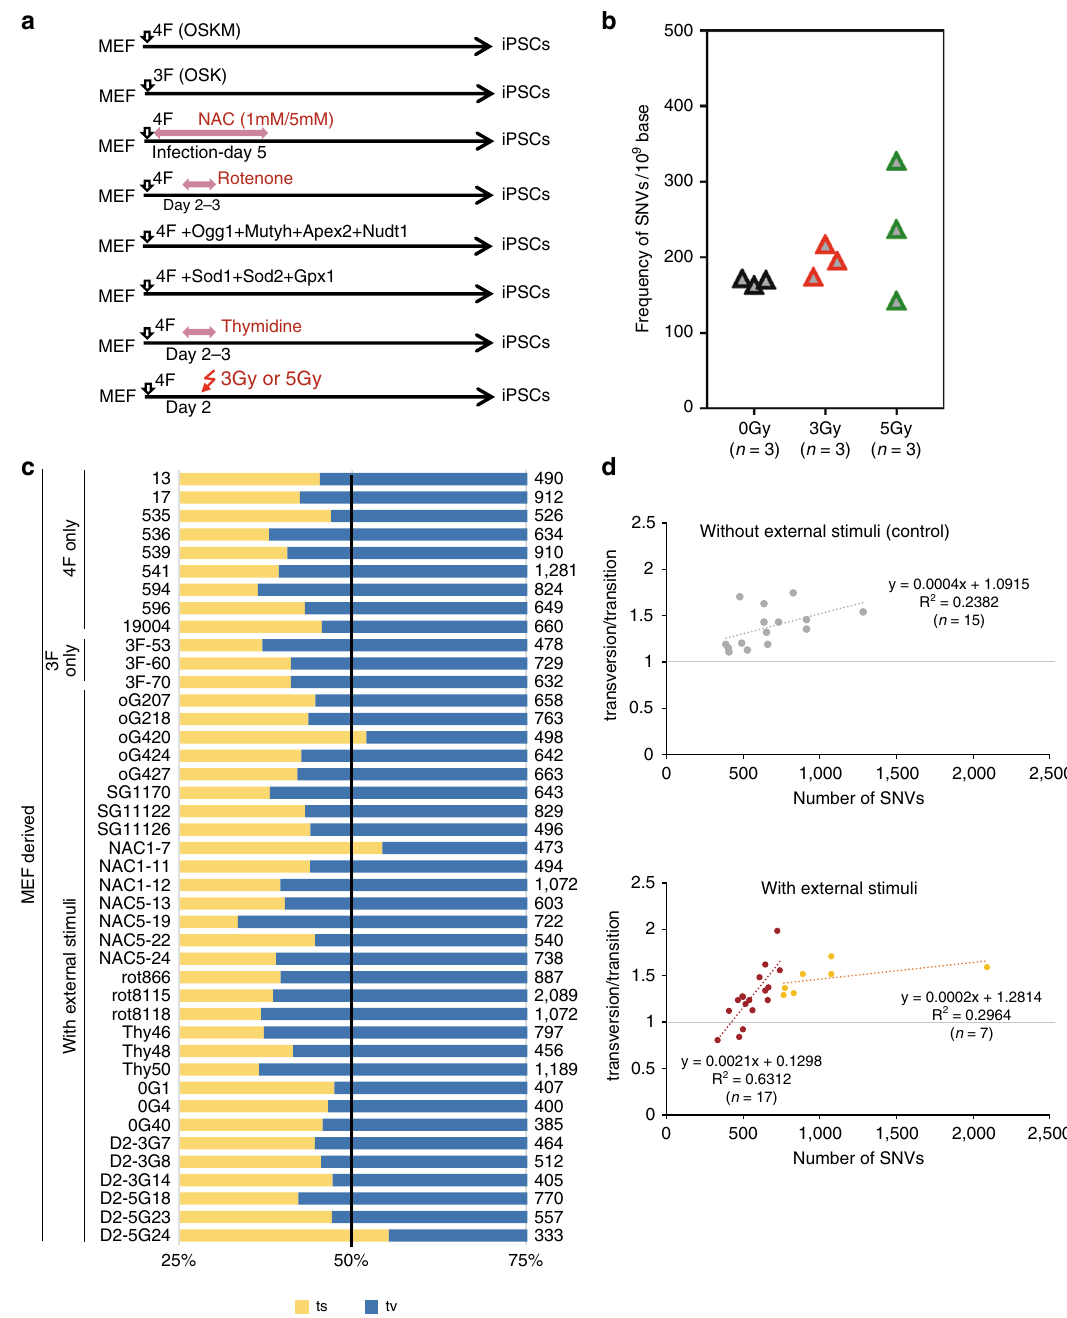
Fig. 8 WGS analysis to assess the effect of external stimuli on the point mutation pro fi le in mouse iPSCs. a Experimental design for mouse iPSC generation. b Effects of IR on the formation of point mutations during iPSC generation (mouse). Cells were exposed to X-rays at 3 or 5 Gy on day 2 ( n = 3 iPSC lines). c The tv/ts ratio and total number (right side of the panel) of identi fi ed SNVs for each clone are shown. To reduce the number of false-positives as much as possible, all iPSC generation experiments were conducted using single embryo-derived MEFs (MEF5). d Effect of external stimuli on the mode of point mutations in iPSC genomes. A high correlation ( R 2 = 0.6312) was revealed between the number of SNVs reduced by external stimuli and the base substitution pro fi le shift from a transversion- to a transition-predominance ( n = 7 – 17 iPSC lines). Source data are provided as a Source Data fi